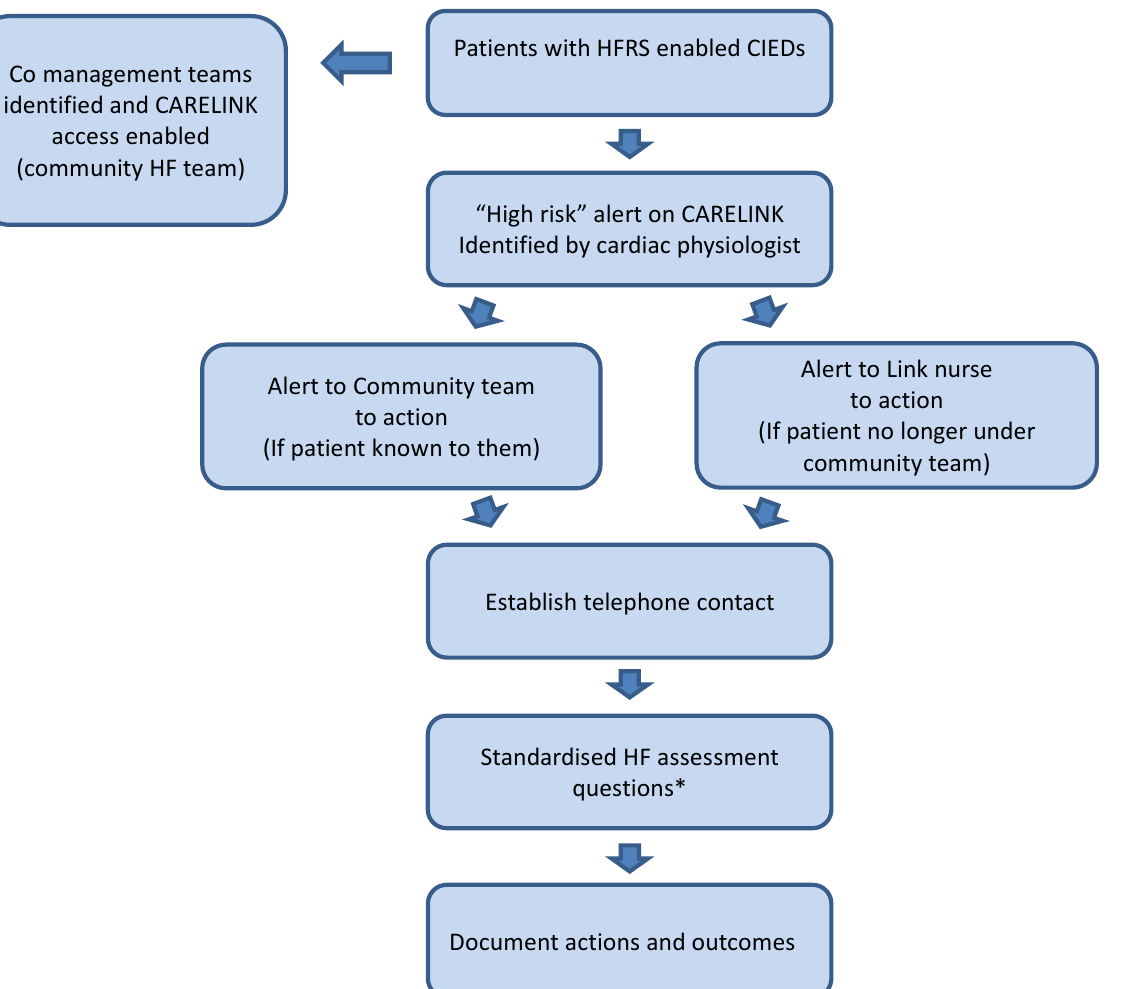
Figure 1. Study protocol. HFRS: Heart failure risk score, CIED: Cardiac Implantable Electronic Device, HF: Heart Failure. * See Appendix A for standardised HF questionnaire.